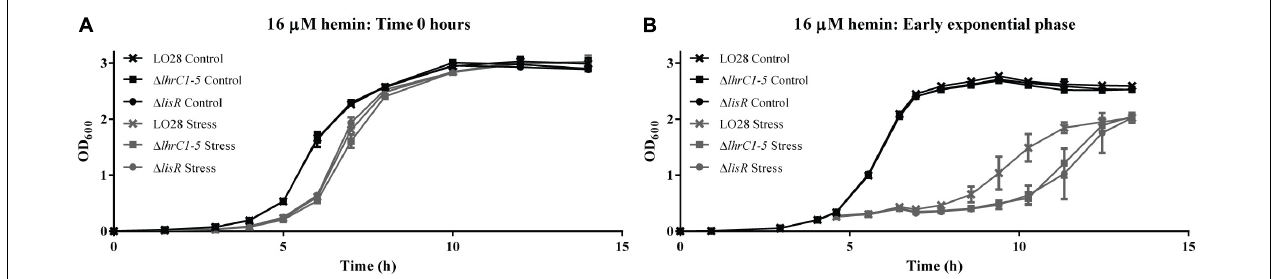
FIGURE 2 | Stress tolerance assay. (A) LO28 wild-type, (cid:49) lhrC1–5 and (cid:49) lisR strains were grown in BHI (Control) and BHI containing 16 µ M hemin (Stress). (B) LO28 wild-type, (cid:49) lhrC1–5 and (cid:49) lisR were grown in BHI to OD 600 = 0.2. Then, the cultures were split in two; one half was stressed with 16 µ M hemin (Stress) and the other half kept unstressed (Control). Bacterial growth was monitored until all cultures reached stationary phase. For each assay, the average of three biological replicates is shown.